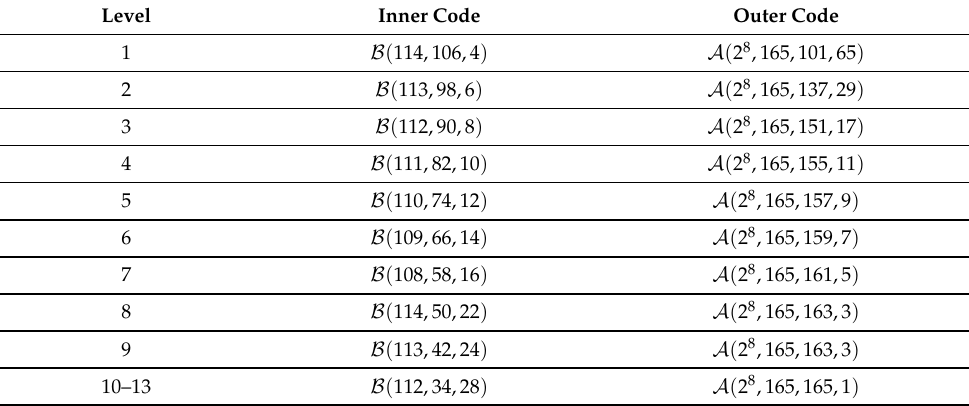
Table 4. Exemplary GC code ( N = 18,810, K = 16,386, R ≈ 0.87) for TLC (designed for WER 10 − 15 ).